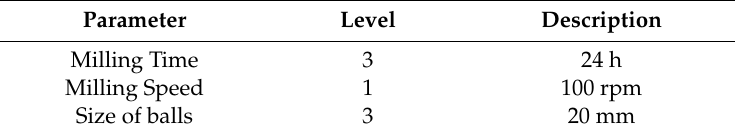
Table 1. Ball milling process parameters.